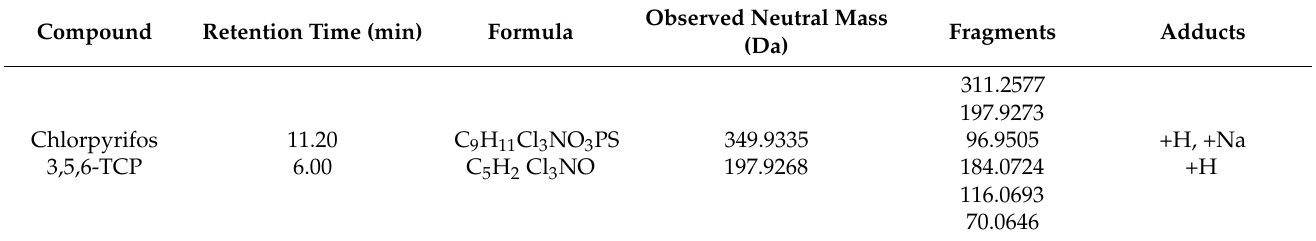
Table 1. Accurate UPLC-QTOF/MS mass measurements of chlorpyrifos and 3,5,6-TCP in wheat samples.